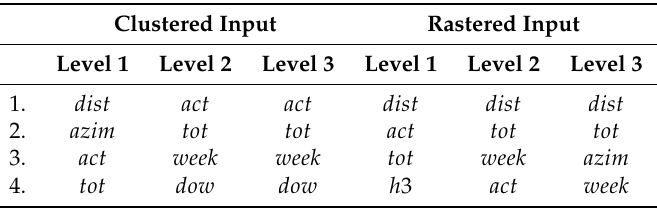
Table 4. Ranking of all features across the different levels and input